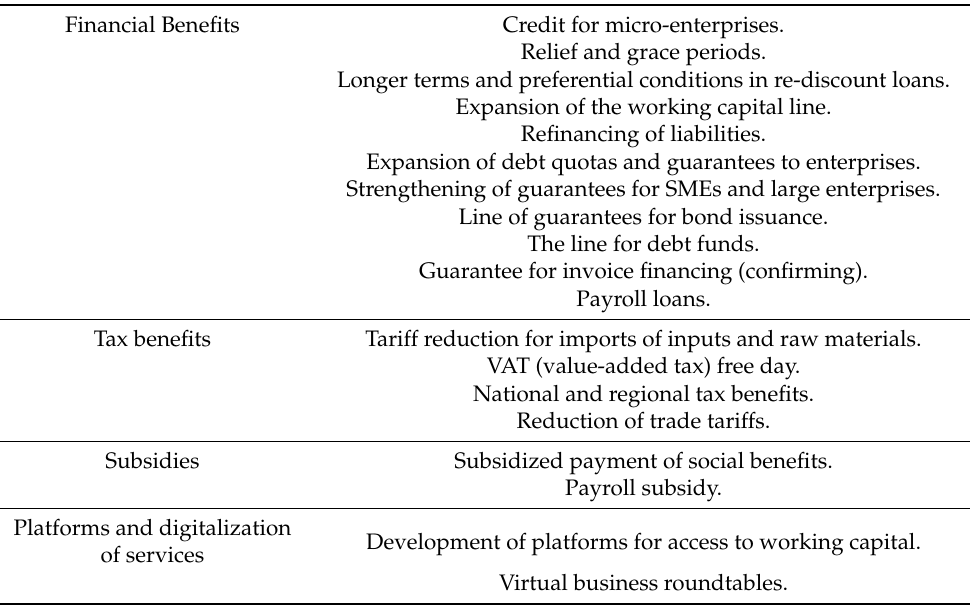
Table 1. Aids designed by the Colombian government to mitigate the impact of the COVID-19 crisis on the business sector. Source: Departamento Nacional de Planeación